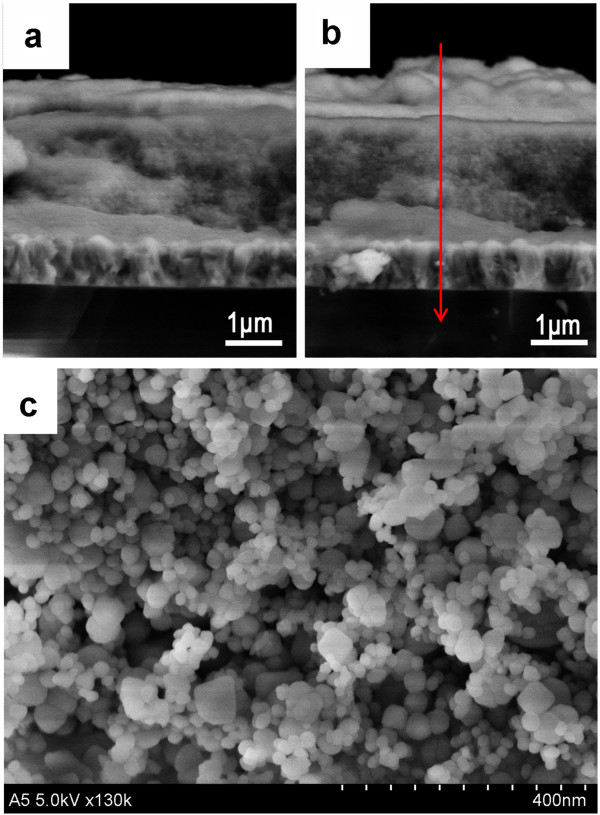
Cross-sectional SEM images of samples with CIS film prepared from (a) 0.03 M or (b,c) 0.1 M InCl3.